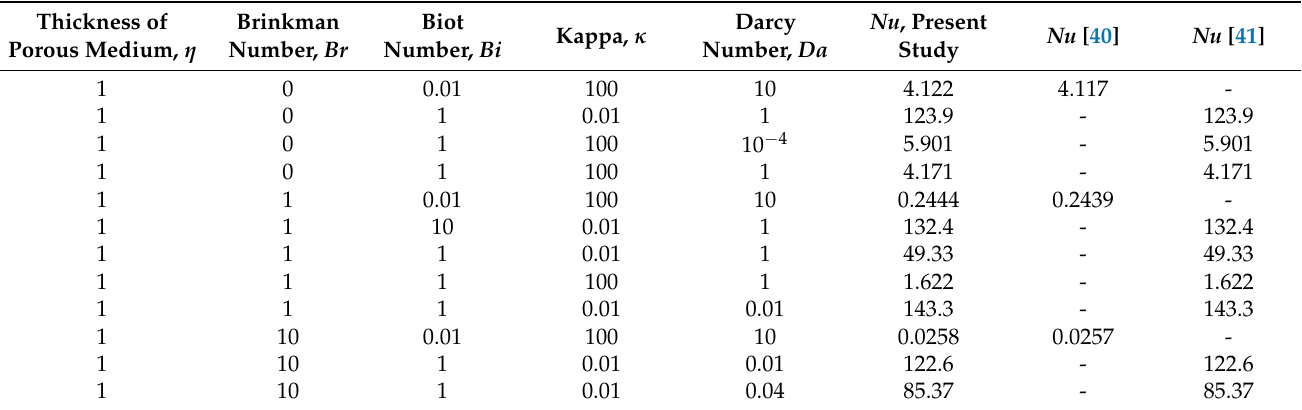
Table 1. Nusselt number comparison with literature for LTNE